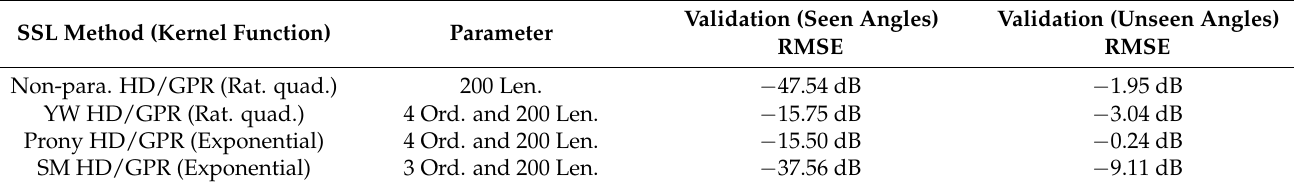
Table 5. Minimum RMSE values for HD/GPR experiments and corresponding parameters. Validation (Seen Angles) Validation (Unseen Angles) SSL Method (Kernel Function) Parameter RMSE RMSE Non-para. HD/GPR (Rat. quad.) 200 Len. − 47.54 dB − 1.95 dB YW HD/GPR (Rat. quad.) 4 Ord. and 200 Len. Prony HD/GPR